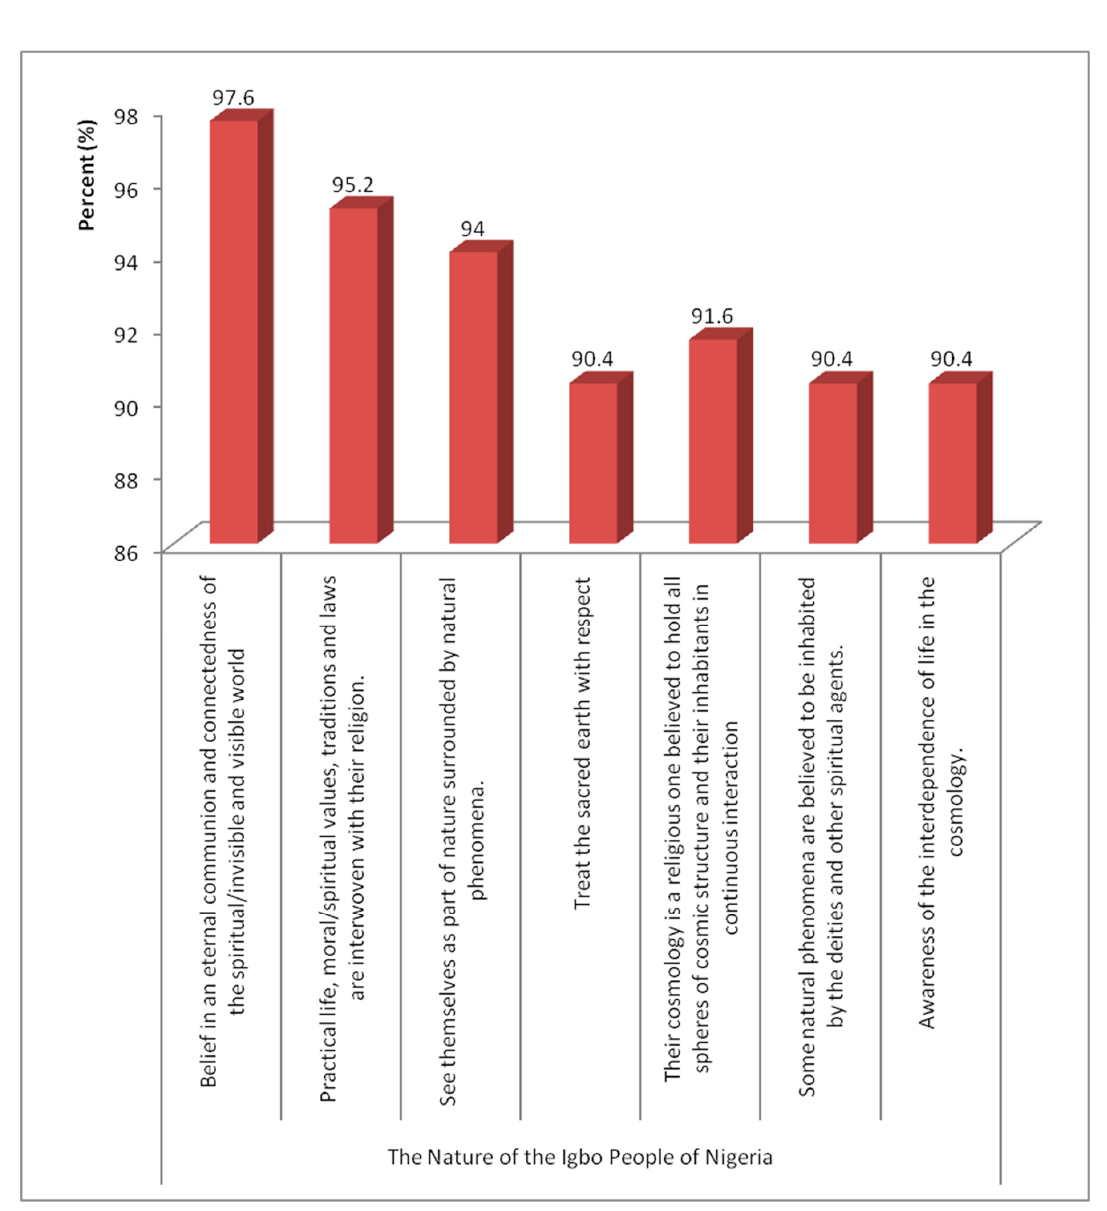
Figure 1. The Nature of the Igbo People of Nigeria. Table 2. Some of the Religio-Cultural Practices of the Igbo that Relate to Ecosystem Preservation. Variables n %